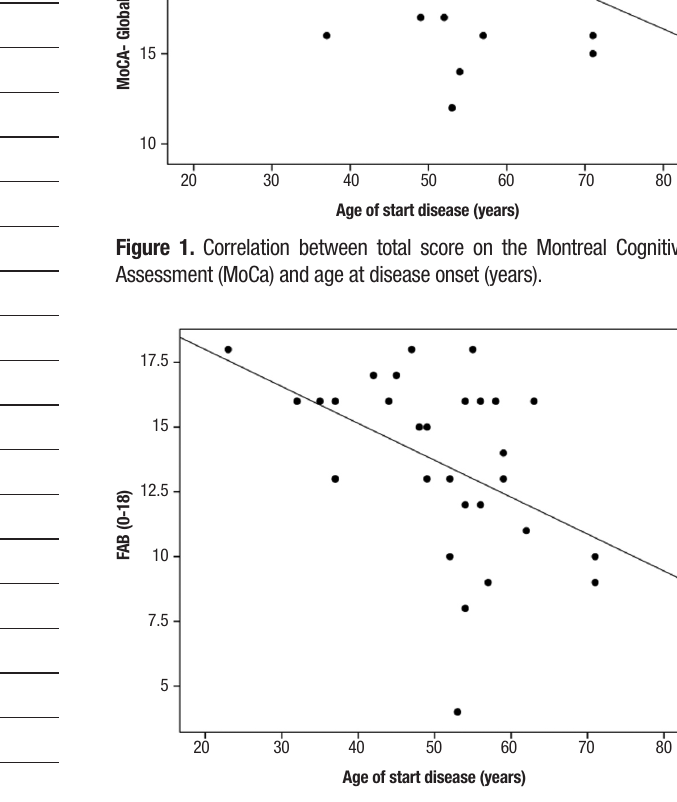
Figure 2. Correlation between total score on the Frontal Assessment Battery (FAB) and age at disease onset